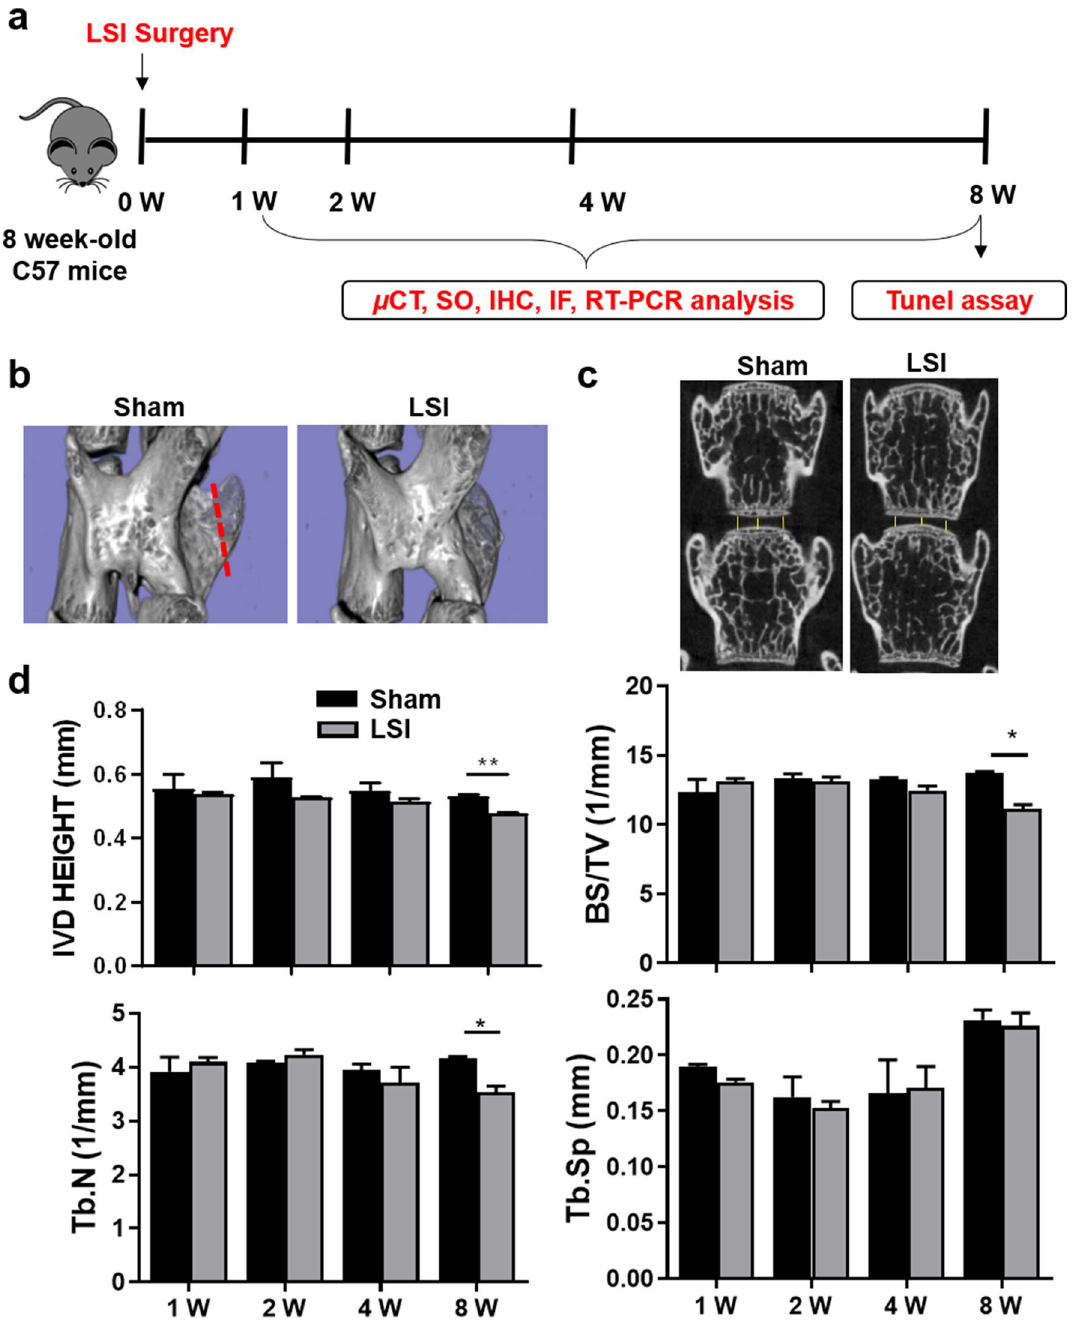
Figure 1. Aberrant mechanical stress reduces the disc height. ( a ) Study design of the project. ( b ) Lumbar spine instability (LSI) mouse model. Mouse L3-L5 spinous processes were resected along with the supraspinous and interspinous ligaments (red dotted line in Sham group) to induce instability of lumbar spine. ( c ) Coronal μCT of the lumbar spine. The images were obtained by using CTVol v2.0 software. The yellow line represents the distance between the middle to middle or side to side of the adjacent vertebra. ( d ) Intervertebral L4-L5 disc height and bone histomorphometry (BS/TV, Tb.N, Tb.Sp) of L5 vertebral body were analyzed at 1-, 2-, 4-, and 8-week (W) post-surgery. Data are shown as mean ± sem. * P < 0.05, ** P < 0.01 compared to Sham that LSI administration resulted in a significant decrease of Aggrecan mRNA levels since 1-week post-surgery (Fig. 3a). Then, we examined protein levels of Aggrecan, Col-II and corresponding matrix-degrading enzymes (Adamts5 and Mmp3, respectively) by immunohistochemistry (IHC) analysis. As shown in Fig. 3b–e, LSI mice exhibited a 54% down-regulation of Aggrecan and threefold upregulation of Adamts5 in the whole disc. Simi- larly, the expression of Col2 and Mmp3 in the EP region showed approximately the same trend as that of Aggre- can and Adamts5, respectively (Fig. 3f–g).